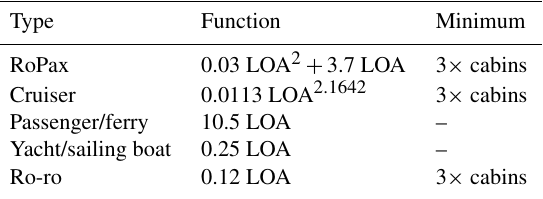
Table 4. Estimation rules used for maximum passenger capacity for different vessel categories. The function shows the computation used for passenger capacity based on LOA (Length overall). The “minimum” states the minimum value for the estimation in case the number of cabins has been specified for the